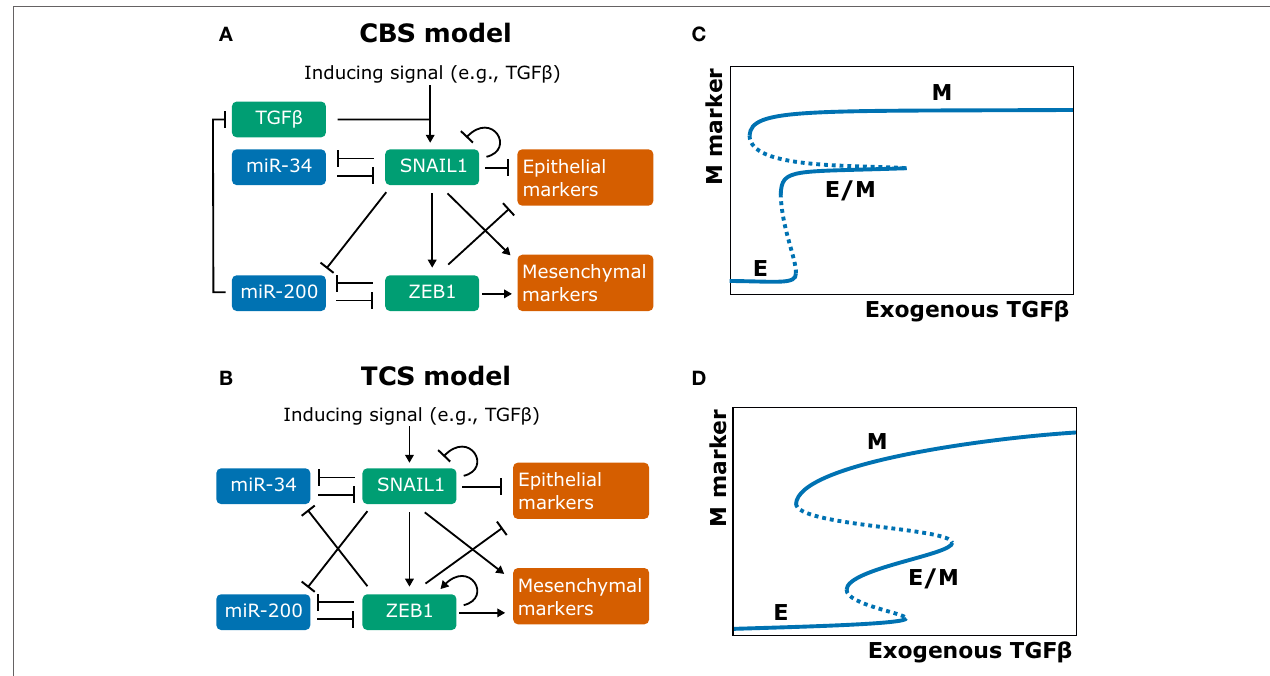
FiGURe 1 | Models of the epithelial–mesenchymal transition core regulatory network and their behavior. (A,B) Network graphs of the cascading bistable switches (CBS) model by Tian et al. (25) and Zhang et al. (26) (A) and of the ternary chimera switch (TCS) model by Lu et al. (27) (B) . (C,D) Bifurcation diagrams corresponding to the CBS model (C) and TCS model (D) [ (B,D) based on Ref. (27); (A,C) based on Ref.